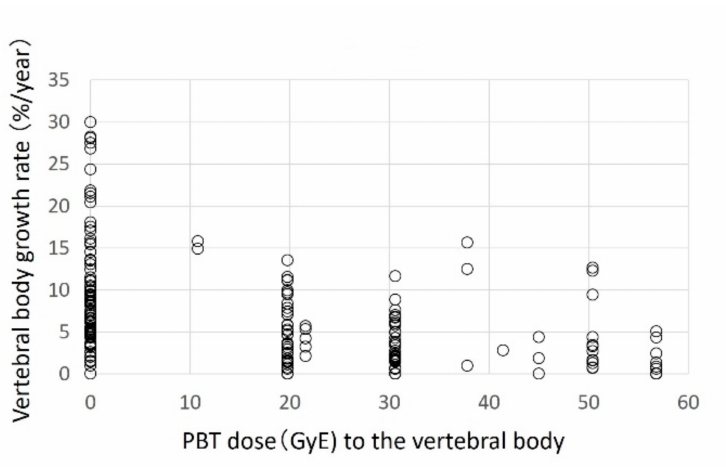
Figure 2. Thoracic vertebral bodies.